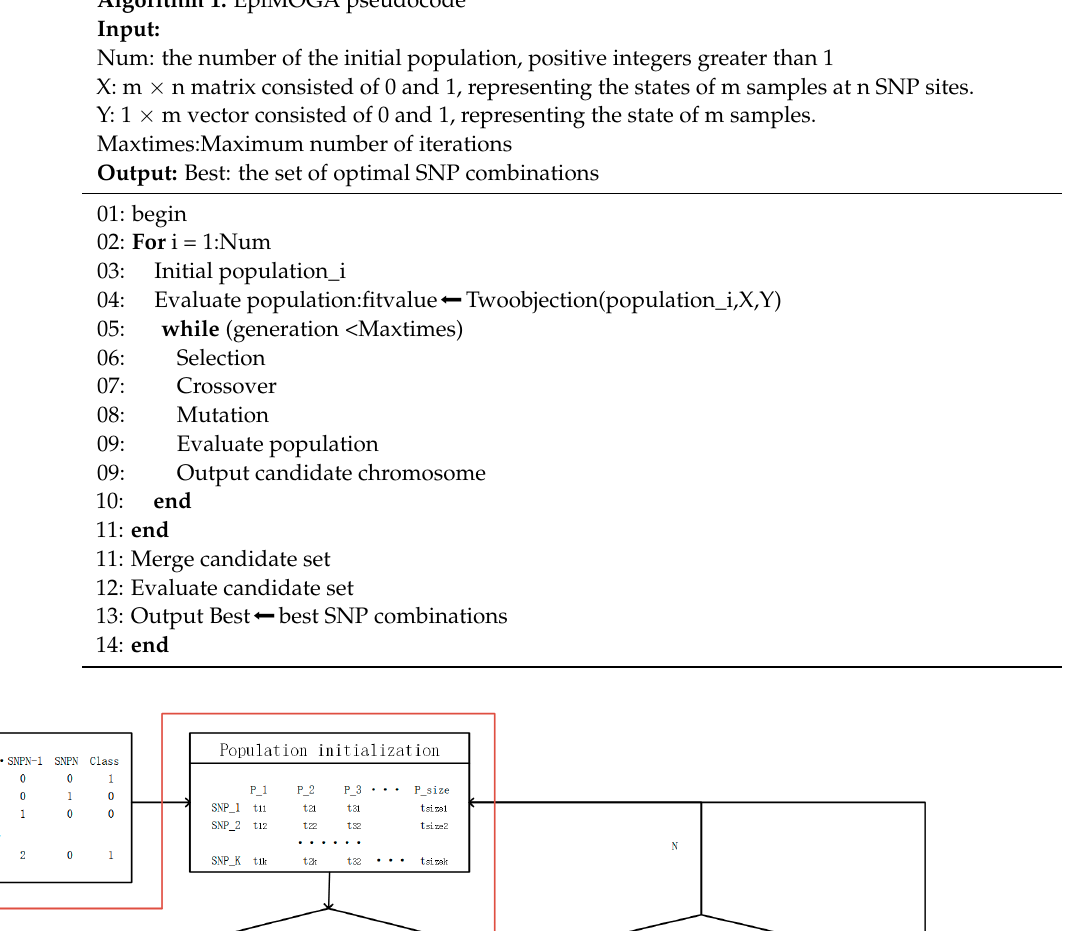
Algorithm 1. EpiMOGA pseudocode